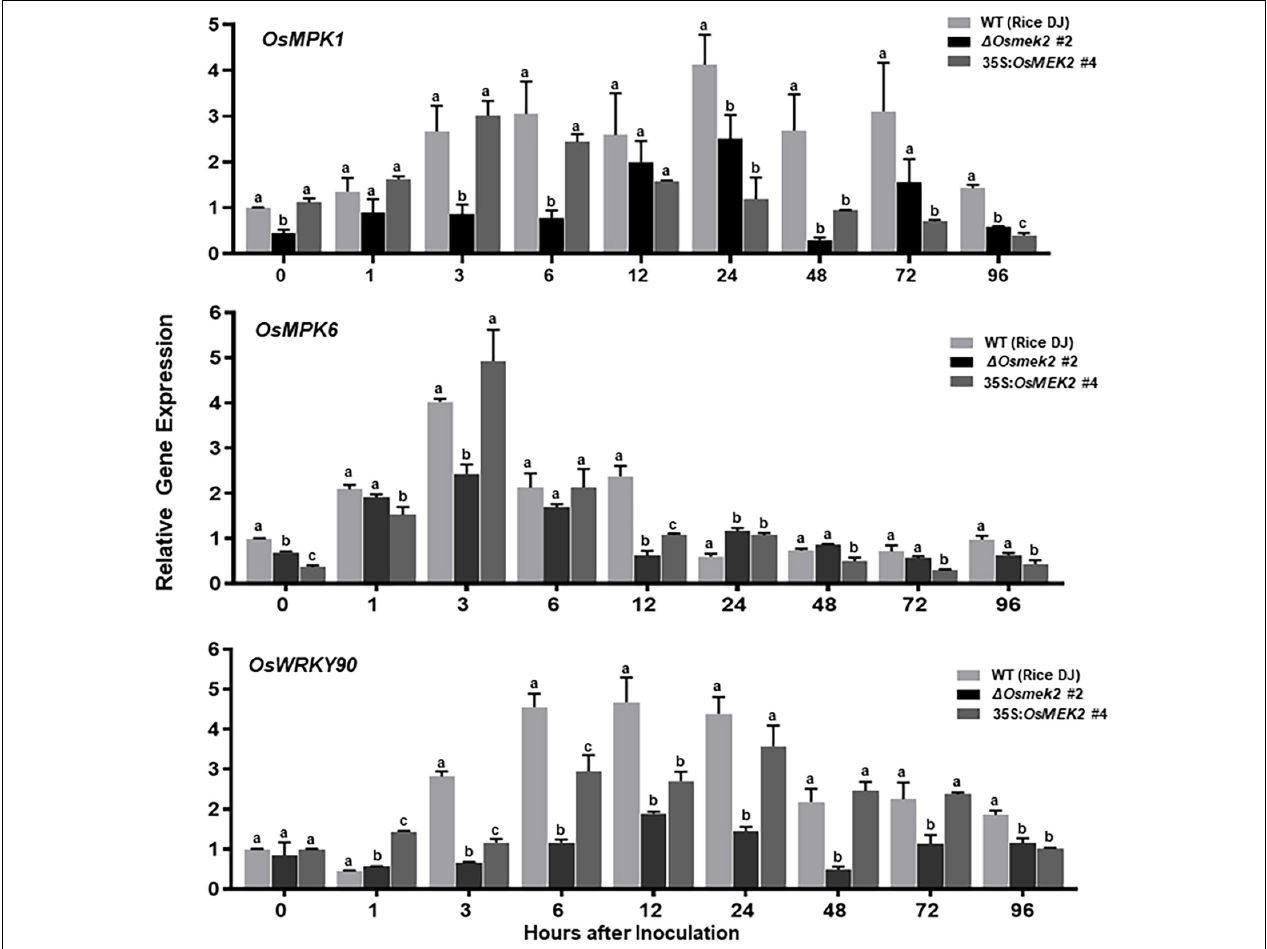
FIGURE 4 | Quantitative real-time RT-PCR analysis of time-course expression of the OsMEK2 interactors OsMPK1 , OsMPK6 , and OsWRKY90 in leaf sheaths of wild-type (WT) rice (cultivar DJ), (cid:49) Osmek2 #2 and 35S: OsMEK2 #4 plants infected with avirulent Magnaporthe oryzae 007. Leaf sheaths of wild-type (cultivar DJ), (cid:49) Osmek2 #2 and 35S: OsMEK2 #4 plants were sampled at different time points after inoculation, followed by total RNA extraction. Relative gene expression of OsMPK1 , OsMPK6 , and OsWRKY90 (Os09g30400) at each time point was obtained by normalizing with respect to the expression of the internal control OsUbiquitin (Os06g46770) gene. Data represent the means ± SD from three independent experiments. Different letters above the bars indicate significantly different means ( P < 0.05), as analyzed by Fisher’s protected least significant difference (LSD) test.